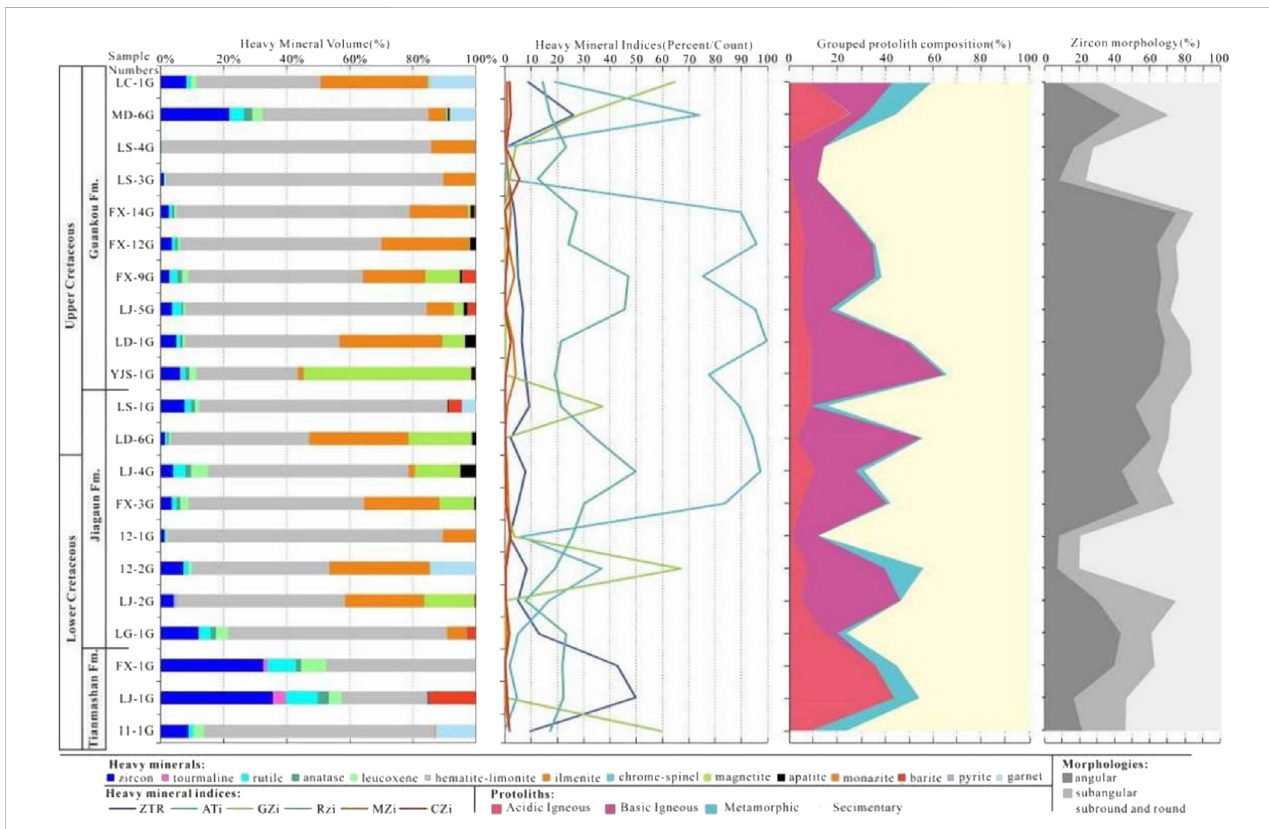
FIGURE 8 Overviewofheavymineralassemblagesinthe63 μ m – 125 μ mfraction,andprovenance-sensitiveheavymineralsindexratios,interpretedprotolithsand varietal morphology of zircon from the Cretaceous sediments in the southwest corner of Sichuan Basin, arranged in reconstructed stratigraphic order. ZTR: zircon-tourmaline-rutile index (zircon + tourmaline + rutile counts); ATi: apatite-tourmaline index [100 × apatite count/(total apatite + tourmaline)]; GZi: garnet-zirconindex[100×garnetcount/(totalgarnet+tourmaline)];RuZi:Rutile-zirconindex[100×Rutile/(rutile+zircon)].MZi:Monazite-zirconindex [100 × monazite count/(total monazite + zircon)]. CZi: Chromium spinel-zircon index [100 × chromium spine count/(total chromium spine + zircon)]. The detailed position of the samples is shown in Figure